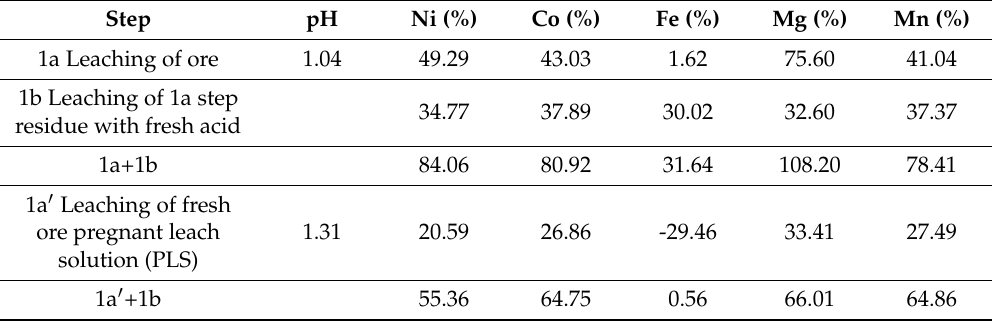
Table 3. Counter-current leaching (CCL) results (acid concentration 2 M, 80 ◦ C, S/L 30%, time 6 h).